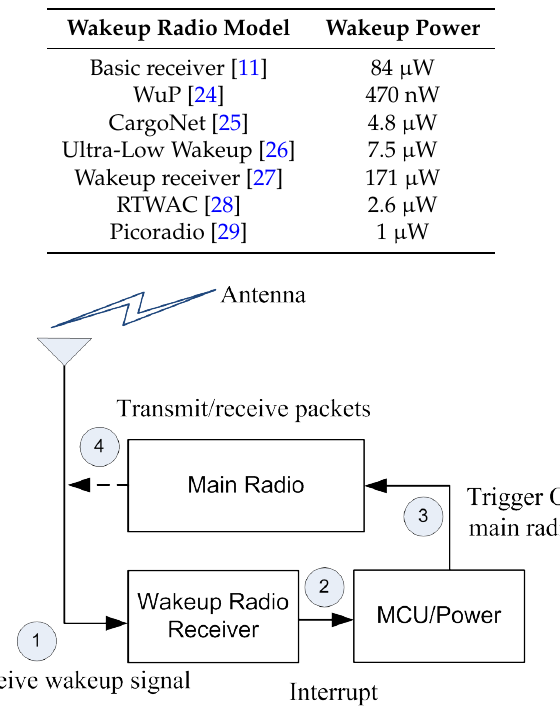
Figure 2. Wake up radio